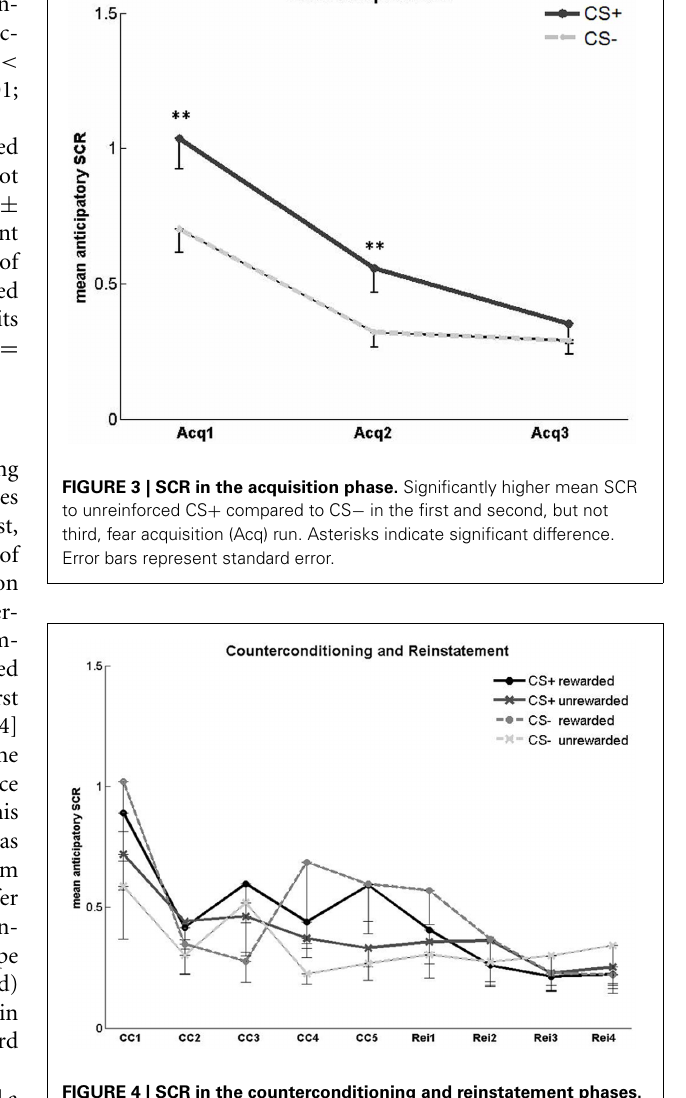
FIGURE 4 | SCR in the counterconditioning and reinstatement phases. Anticipatory SCR for each trial in the counterconditioning (CC) and reinstatement (Rei) phase. Error bars represent standard